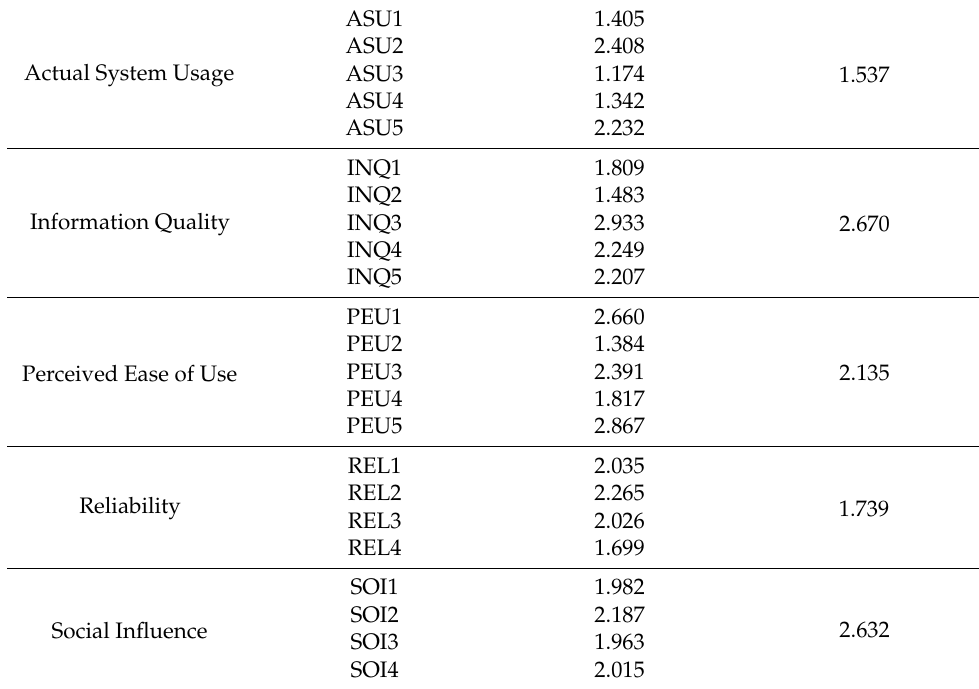
Table 5. Variance Inflation Factor